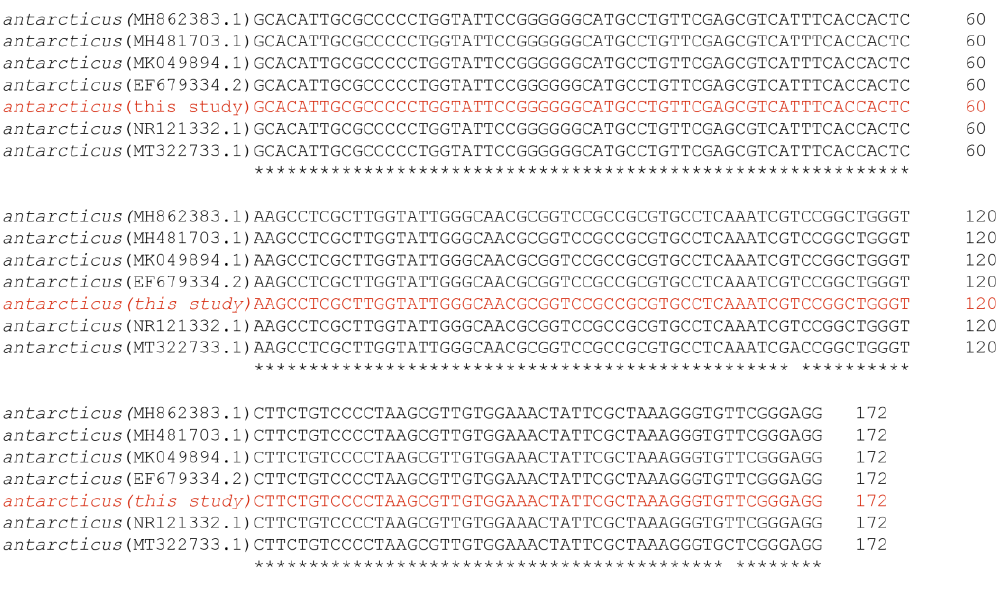
Figure 2. Multiple sequence alignment of the ITS region of the Cladosporium antarcticum strains, in red. The strain accession numbers are in